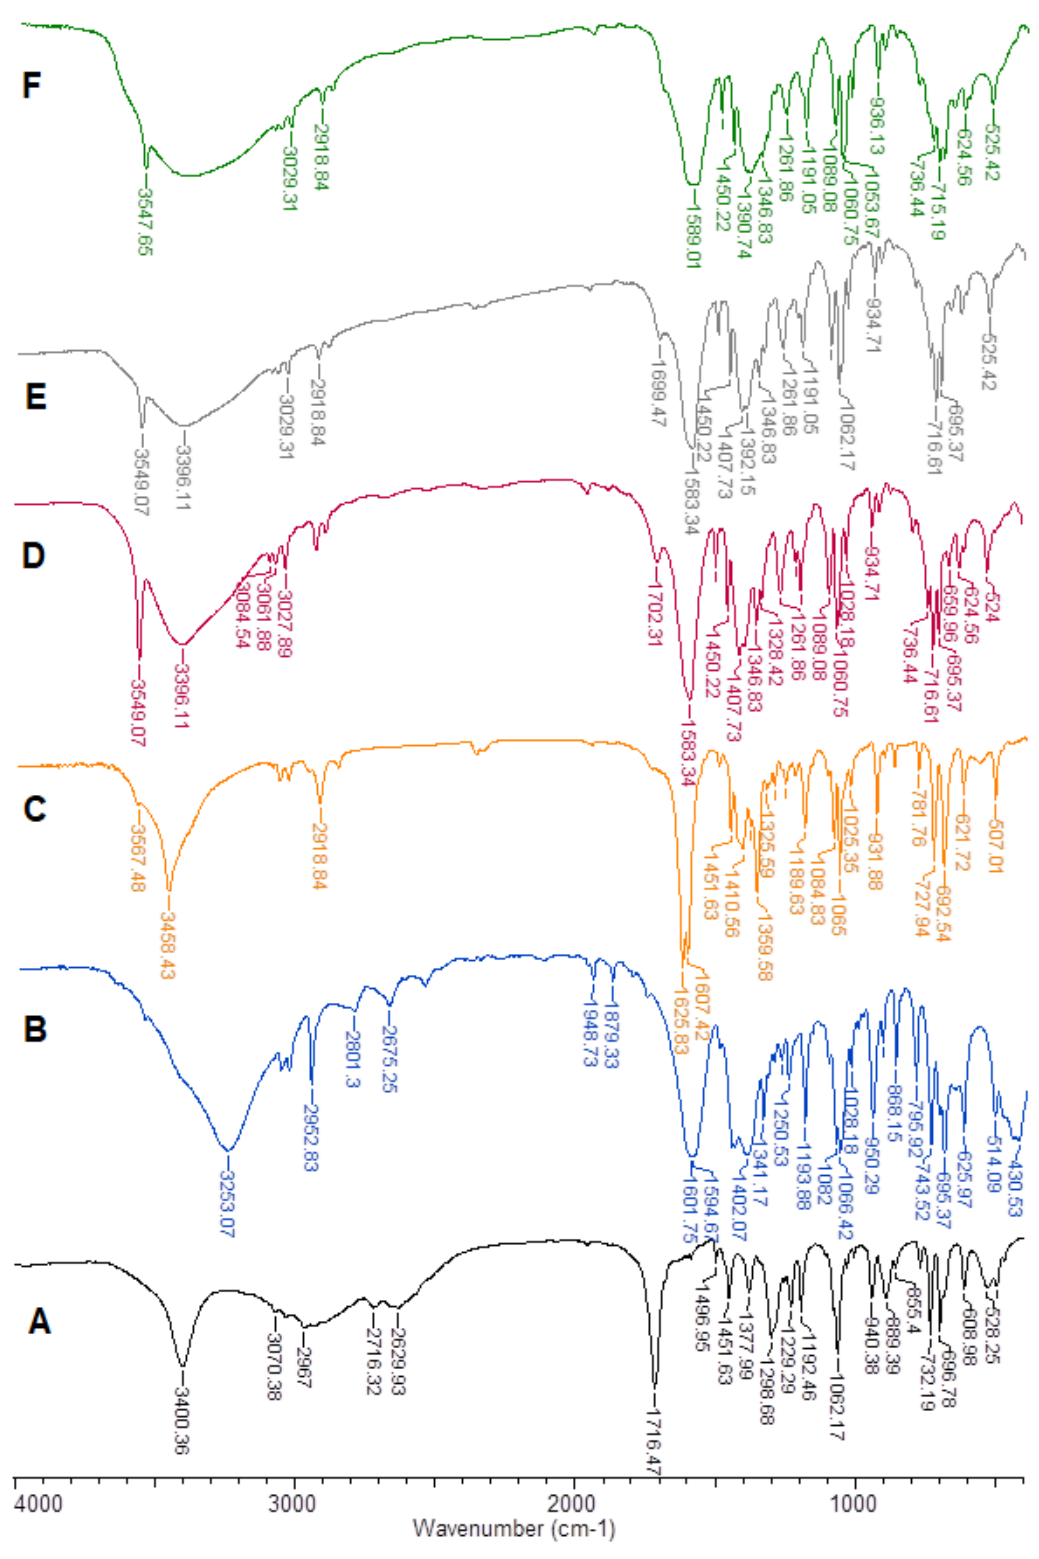
Figure 1. FT-IR spectra for mandelic acid ( A ) and lithium ( B ), sodium ( C ), potassium ( D ), rubidium ( E ), and cesium ( F ) salt of mandelic acid registered in KBr pellets.